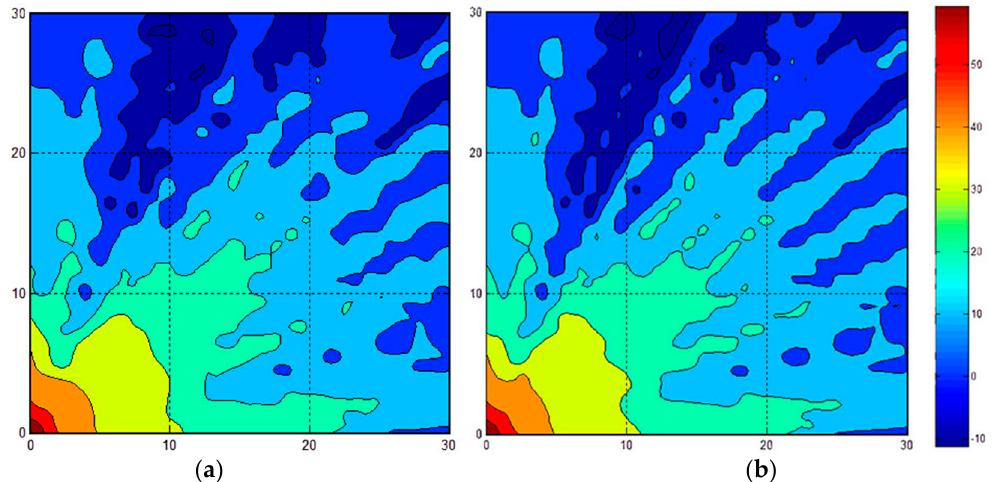
Figure 7. WAF = 6.4 with 600 feedbacks. ( a ) The strength mapping using our proposed method ( b ) The total resampling result with Equation (1).